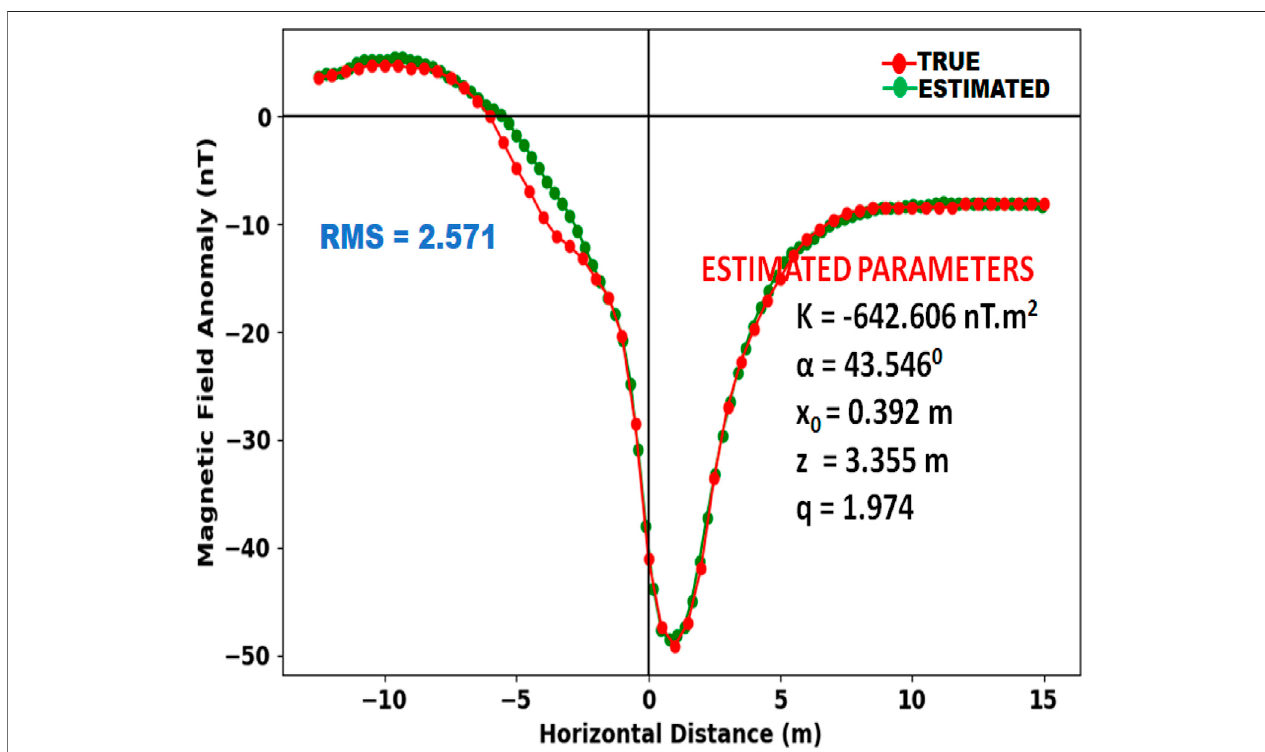
FIGURE 11 | Magnetic anomaly pro fi le over the Parniaba fi eld anomaly using the MRF algorithm.